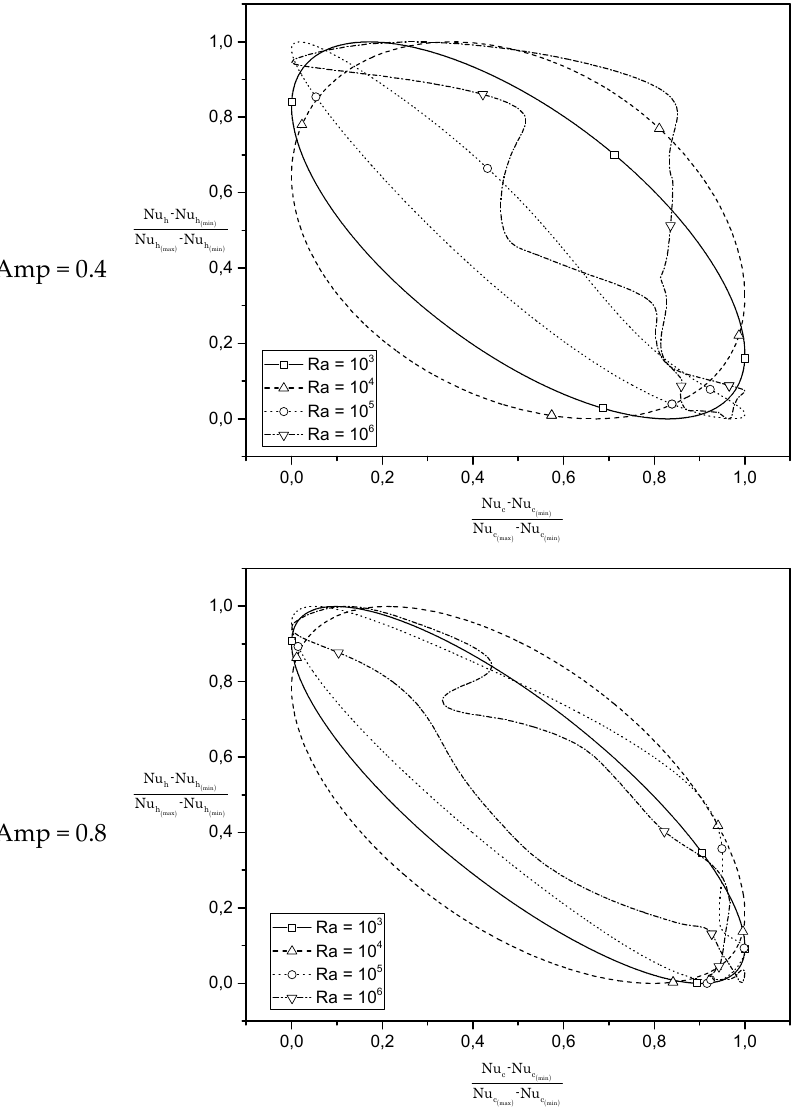
Figure 10. Phase plot for the normalized Nu c and Nu h for different Ra (Amp = 0.4 and 0.8).